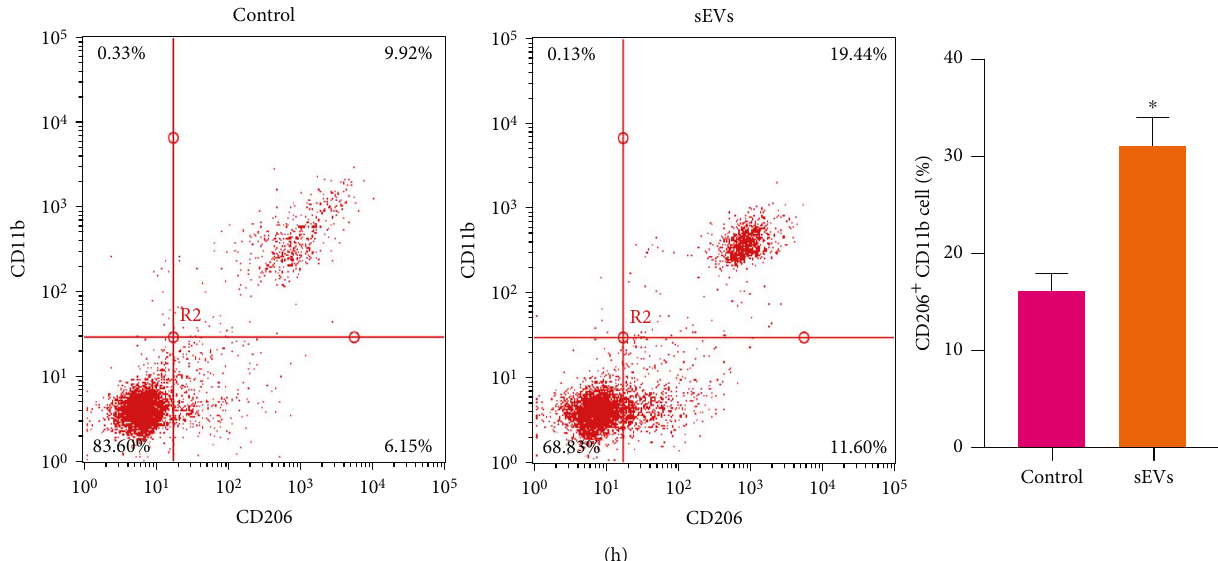
Figure 1: OSCC-CSC-derived sEVs (OSCC-CSC-sEVs) promote M2 polarization of macrophages. (a) CD133 + CD44 + cell immuno fl uorescence staining synthesis map (left panel) and CD133 - CD44 - cell immuno fl uorescence staining synthesis map (right panel, 500 × ). (b) The formation of spheres, observed under an optical microscope (200 × ). (c) The sEVs derived from OSCC-CSCs, observed under a transmission electron microscope (10000 × ). (d) Determination of exosome diameter by nanoparticle tracking analysis. (e) Western blot analysis detecting the exosome surface markers CD81 and CD63. (f) The uptake of sEVs by macrophages, observed under a confocal fl uorescence microscope (200 × ). (g) Detection of M2 macrophage markers (CD163, IL-10, and Arg-1) by RT-qPCR after coculture of macrophages and OSCC-CSC-sEVs. (h) Detection of CD206 + CD11b + M2 macrophages by fl ow cytometry after coculture of macrophages and OSCC-CSC-sEVs. ∗ p < 0 : 05 . All cell experiments were repeated three